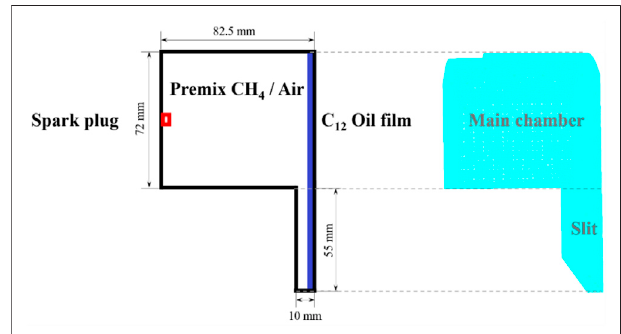
FIGURE 2 | Left plot: Schematic of the methane-air mixture, ignition sourceandfuel fi lmplacedonthecombustionchamberwall(2Dmodel);Right plot: Schematic of the computational domain a cylindrical constant volume combustion bomb (3D